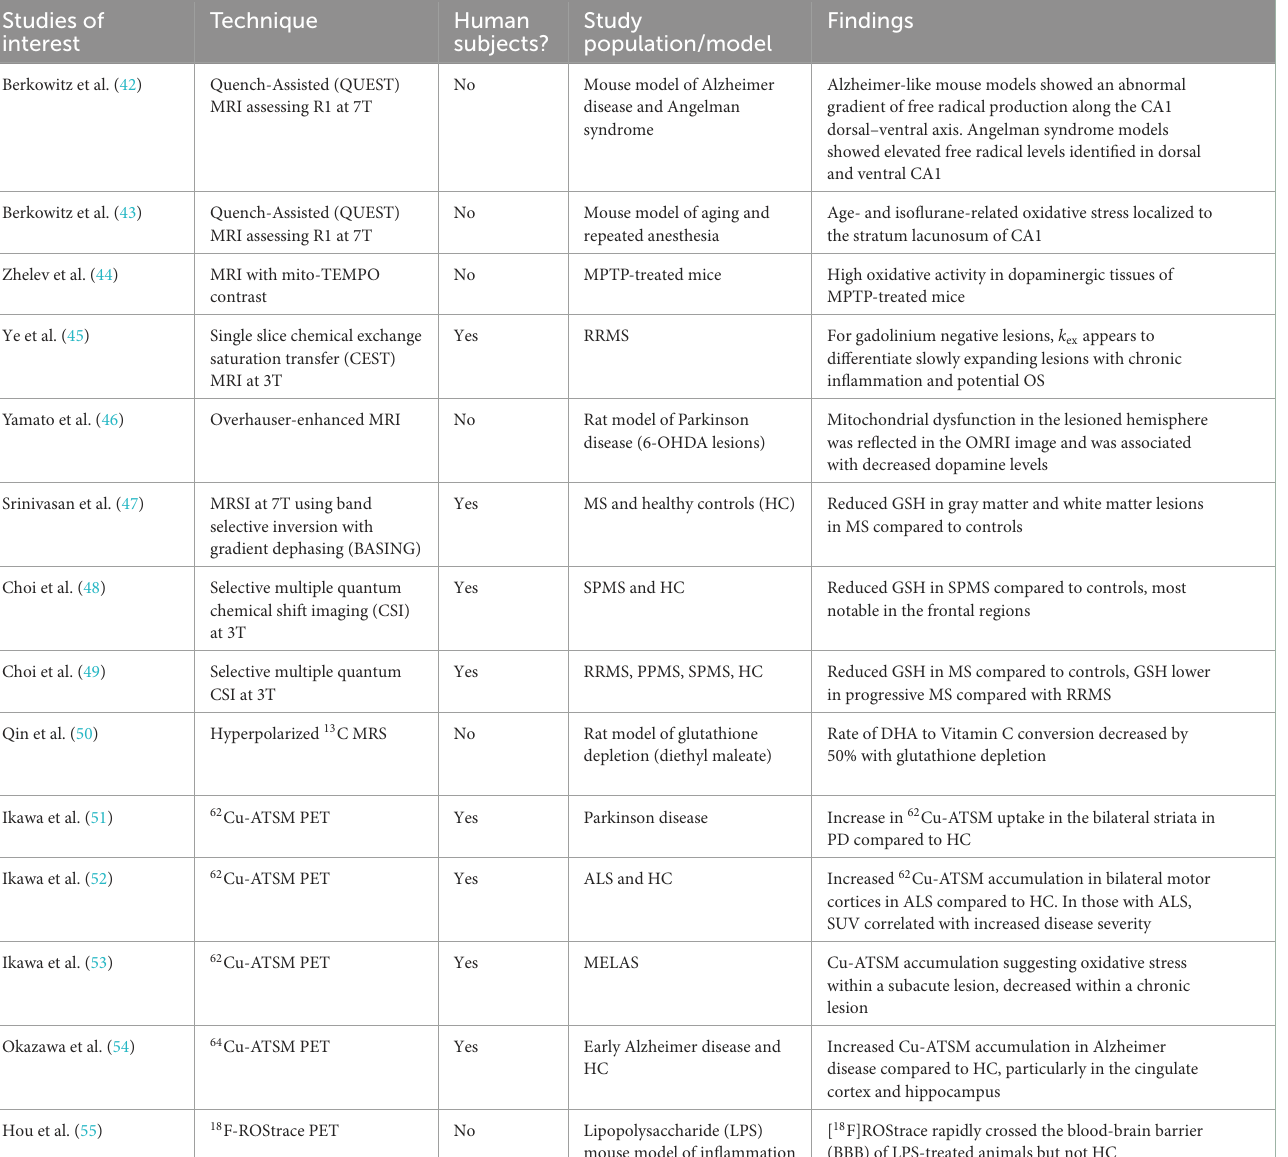
TABLE 1 OS imaging techniques used in MS and other neurodegenerative disease models in vivo